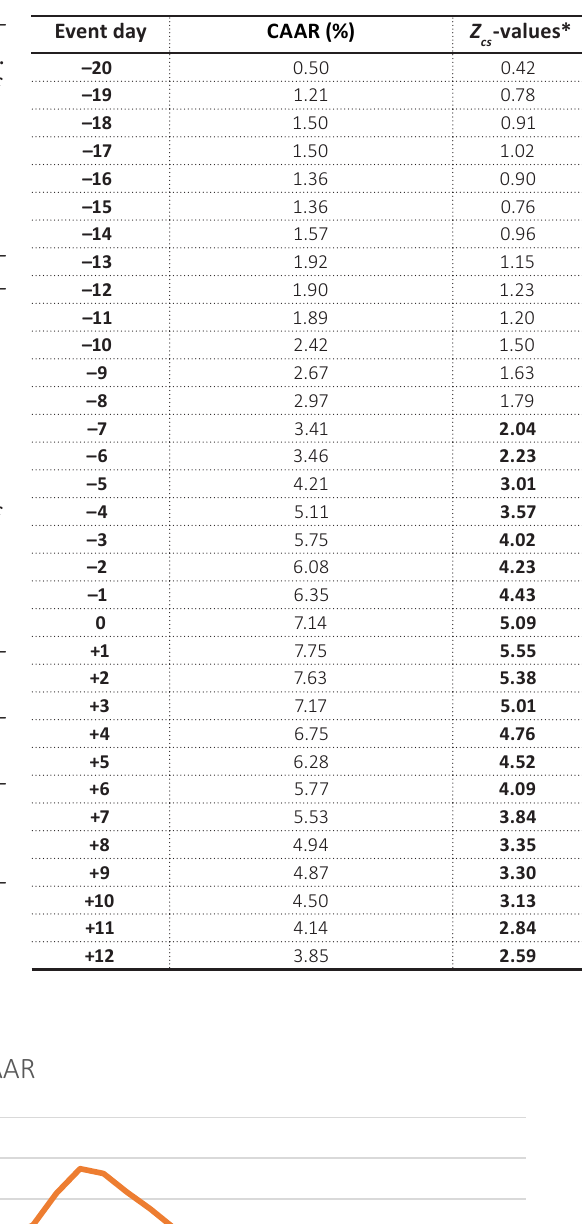
-values (announcement day) cs